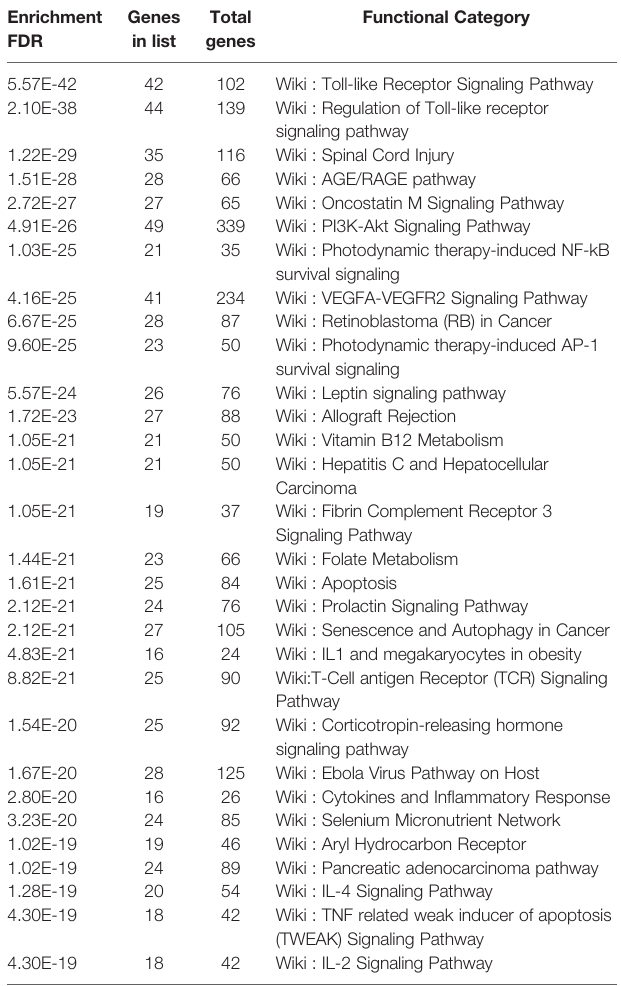
TABLE 1 | Results of pathway enrichment analysis through